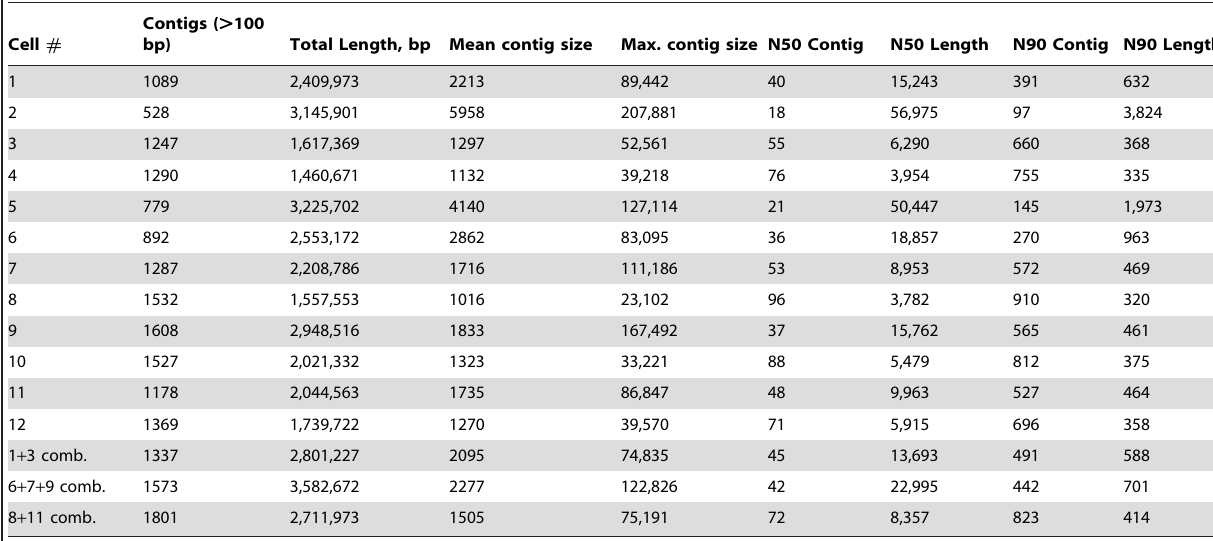
Table 1. Characteristics of whole genome assemblies derived from individual Tannerella BU063 cells and combined data from highly identical